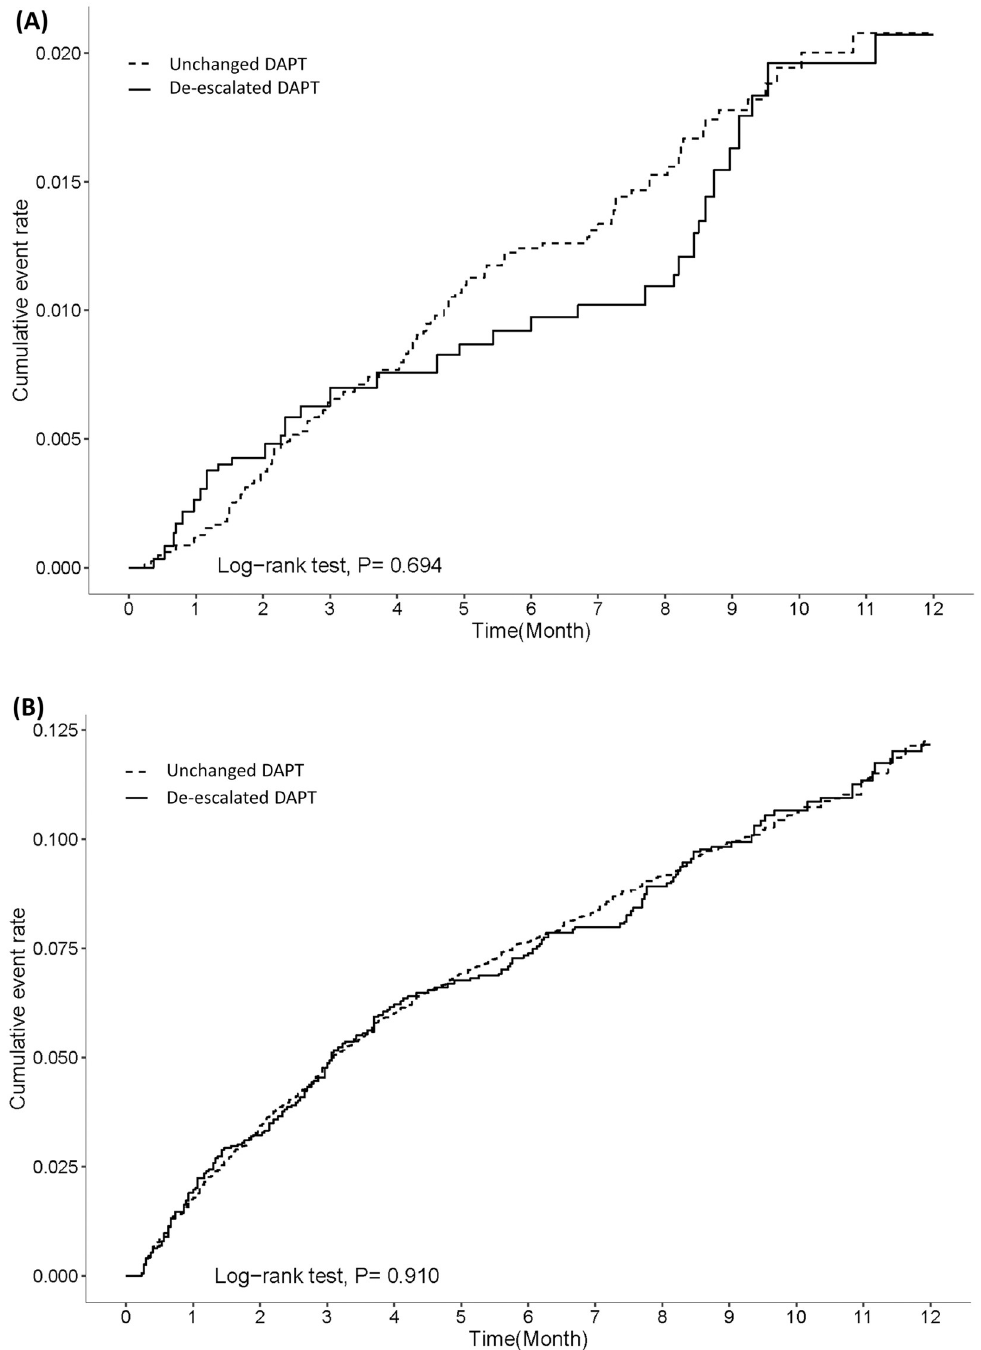
Fig 3. Kaplan-Meier curves along with adjusted hazard risk for safety outcomes between unchanged and de-escalated groups. A) Major bleeding. B) Non-major clinically relevant bleeding.